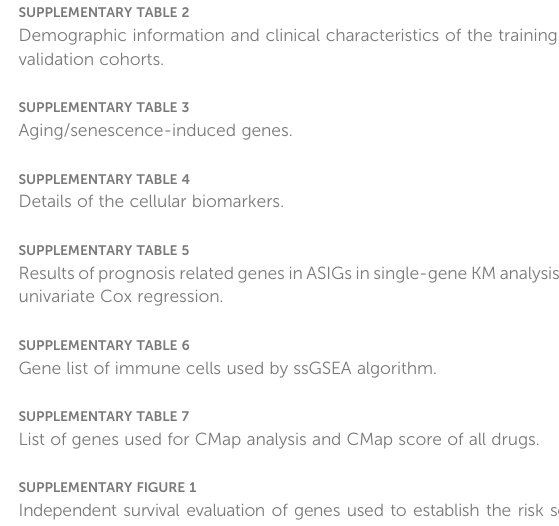
SUPPLEMENTARY TABLE 6 Gene list of immune cells used by ssGSEA algorithm. SUPPLEMENTARY TABLE 7 List of genes used for CMap analysis and CMap score of all